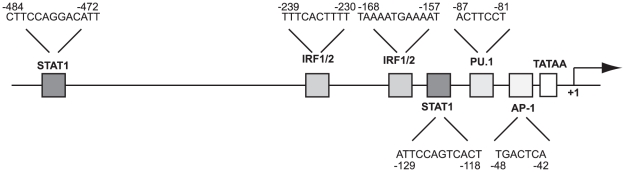
Putative regulatory elements within the Slfn4 promoter.The Slfn4 proximal promoter is a TATA-containing promoter with putative binding sites for STAT1, IRF family members, PU.1 and AP1. The TSS, designated +1, is marked with an arrow.